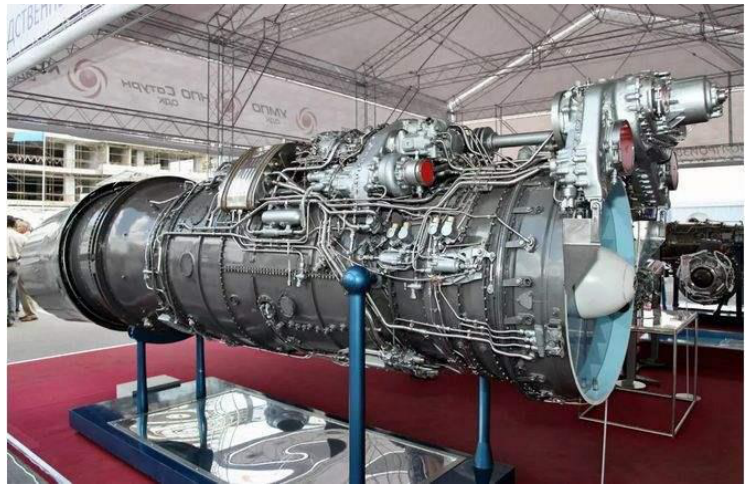
Figure 1. Complex tube system of the aircraft engine.